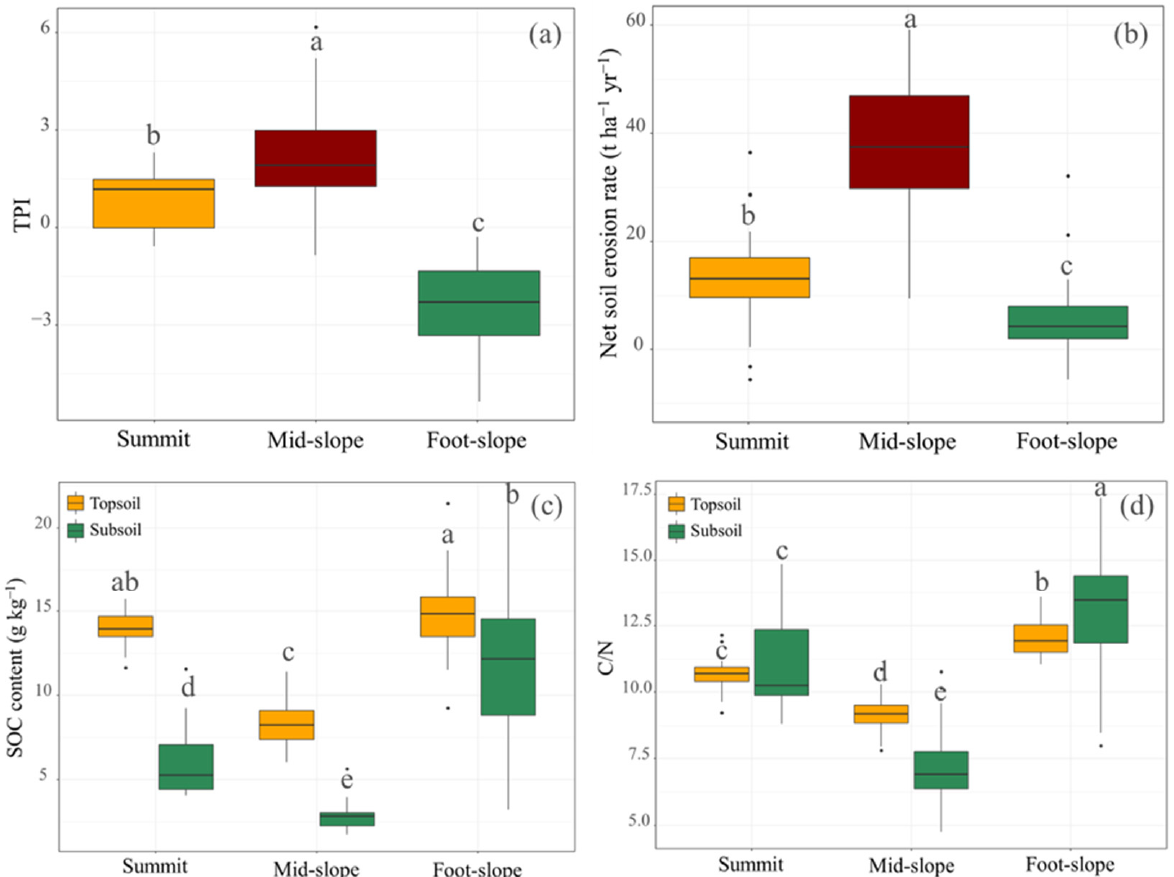
Figure 2. ( a ) Topographic position index (TPI), ( b ) estimated net soil erosion rates converted from 137 Cs inventory, ( c ) soil organic carbon (SOC) content and ( d ) C/N ratio at Summit, Mid-slope and Foot-slope positions. Different letters indicate significant differences among the three groups ( p < 0.05).